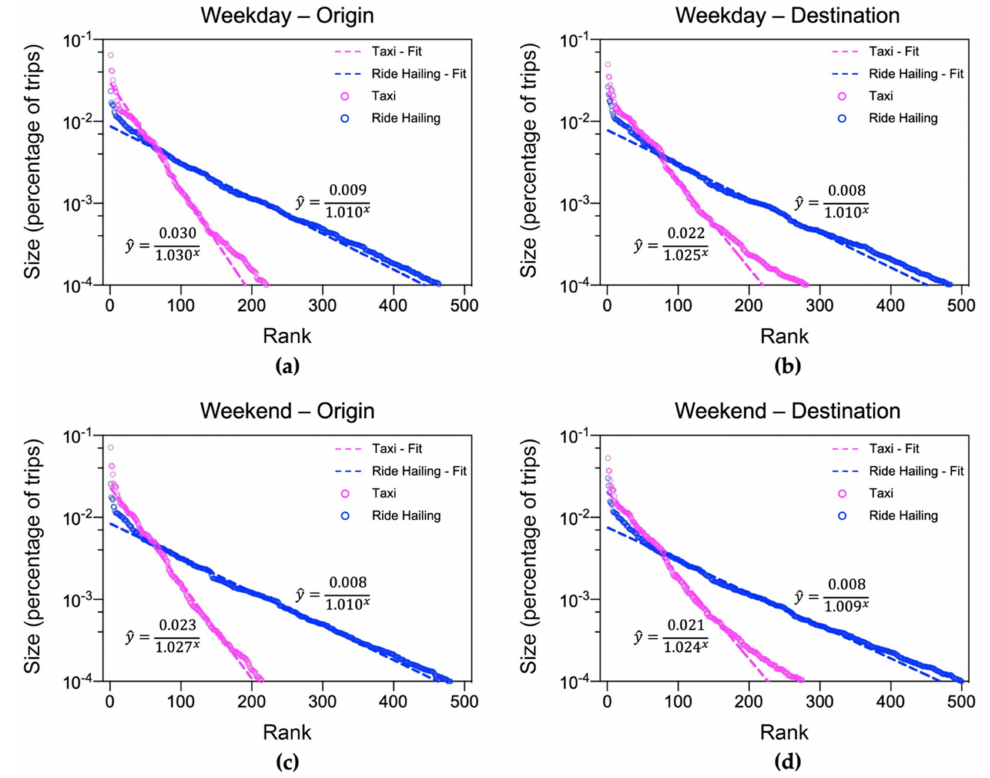
Figure 8. Rank–size distributions for each case by origin and